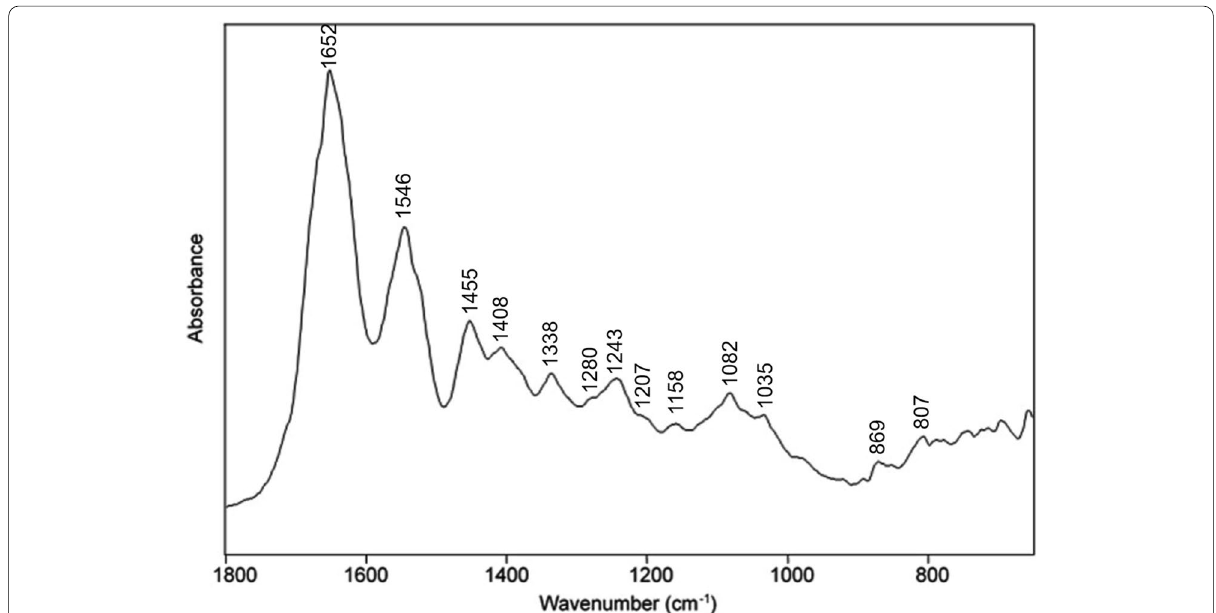
Fig. 1 Micro-FTIR spectrum in the diamond cell of a sample of the yellow residue from the painting